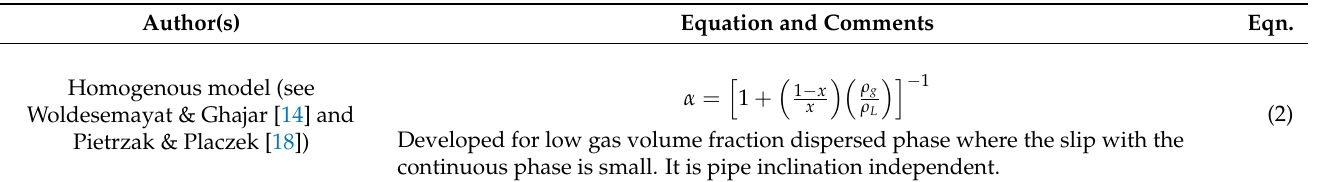
Table 1. Summary of correlations for liquid holdup/void fraction